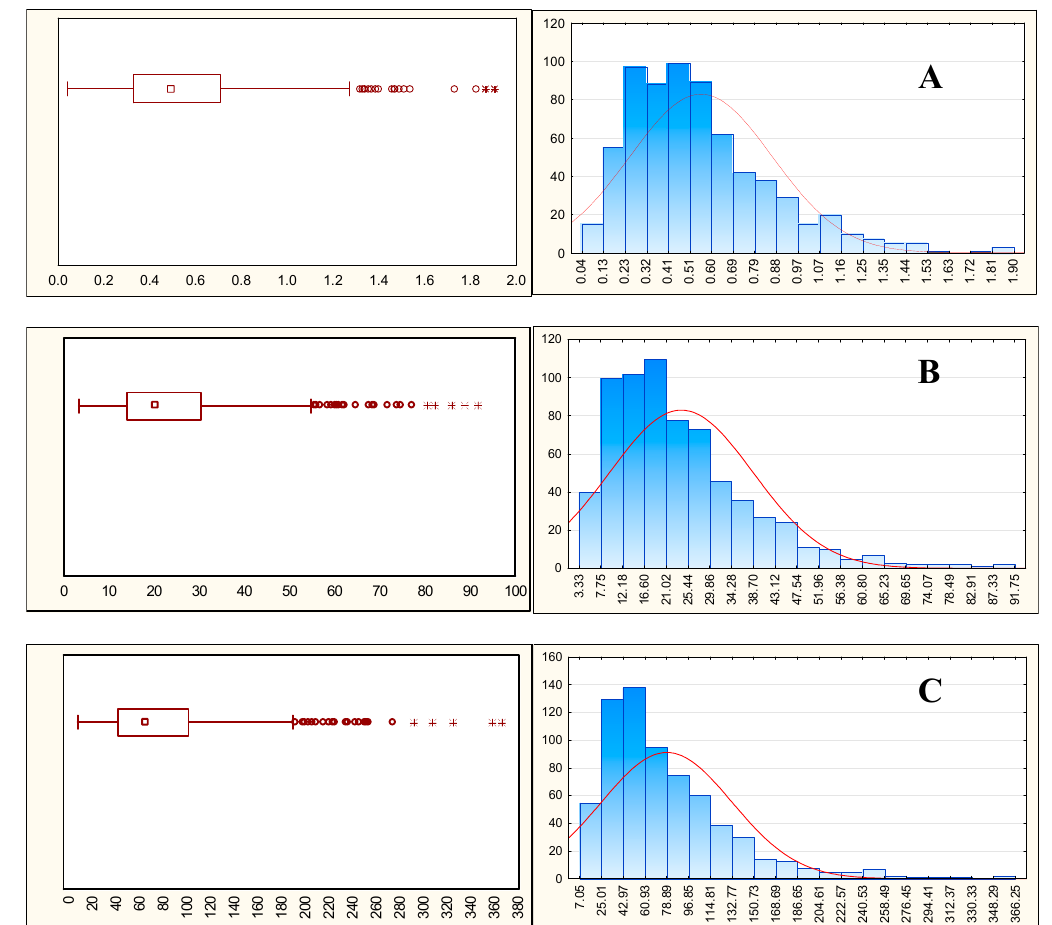
Figure 6. Box plots (90% confidence interval) and graphic distribution of metabolites with ( A ) low (5-HT, median 0.492 μ M), ( B ) medium (XA, median 5.424 μ M) and ( C ) high median (TRP, median 64.02 μ M) levels quantified in urine in the DONALD study ( n = 672) .